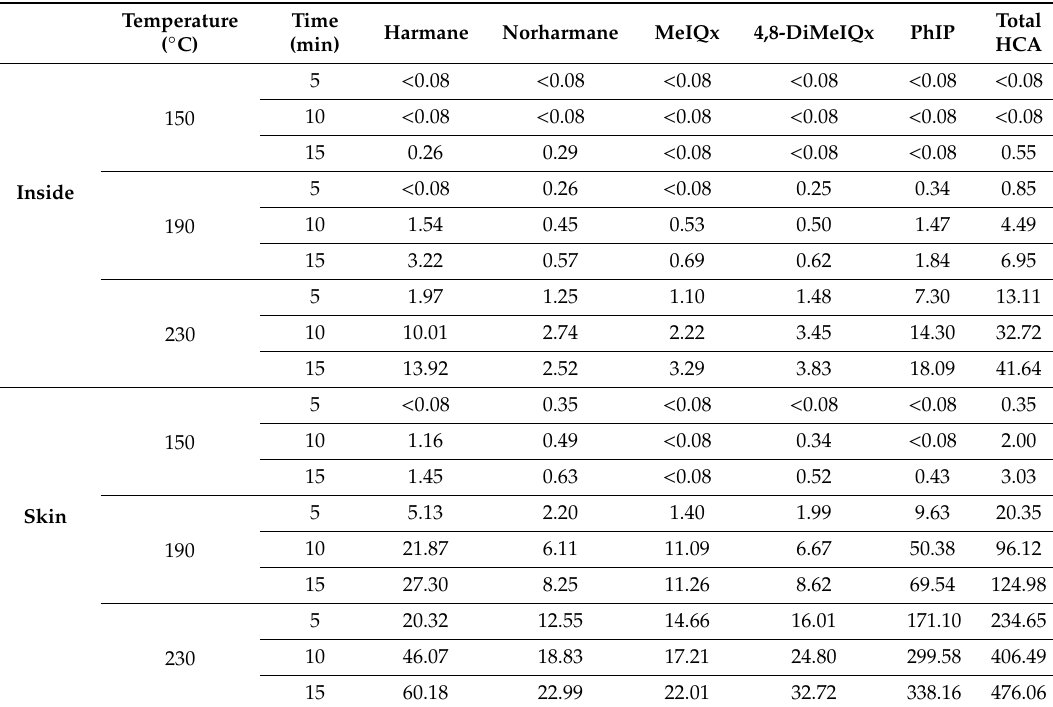
Table 5. Heterocyclic amine content of samples with skin, grilled opened (ng / g).